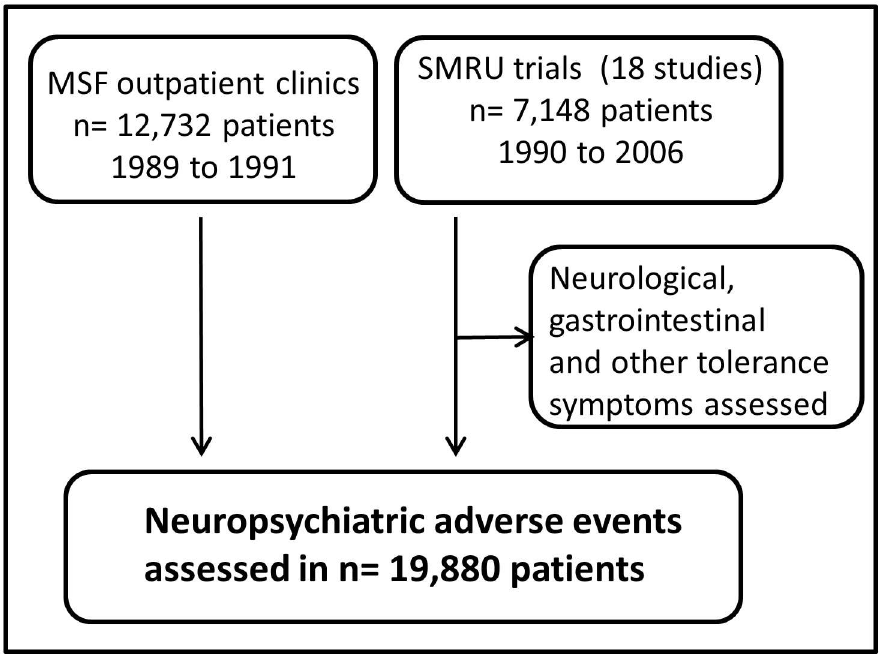
Fig 1. Overviewof studies evaluated for neuropsychiatric adverseevents. MSF: Me´decins sans Fronti è res; SMRU: Shoklo Malaria ResearchUnit. These studies have beenpublished:[13,14,34–48].